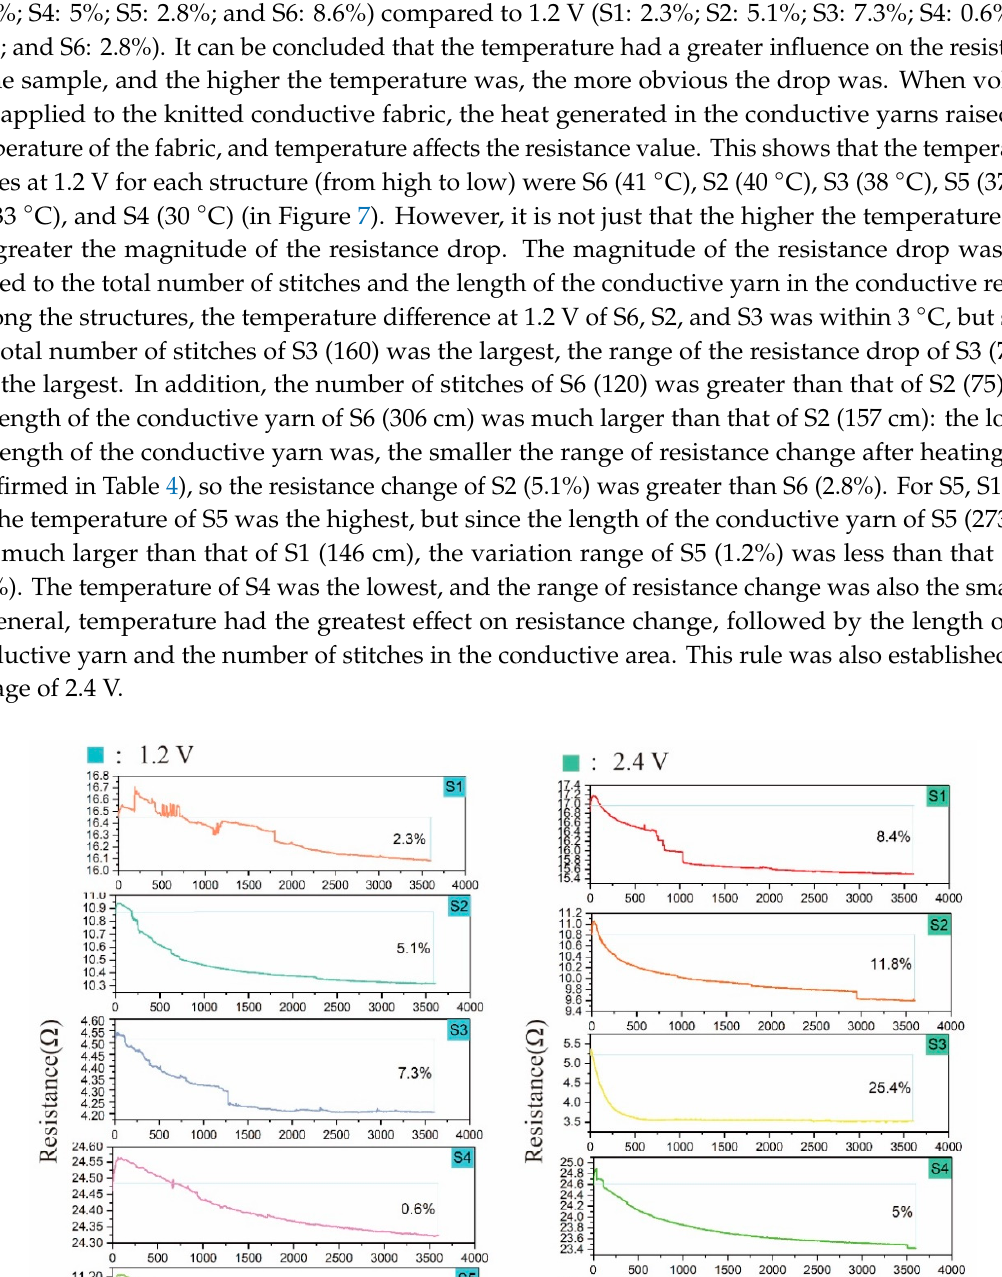
Figure 6. Current values of S1–S6 at 2.4 V in the first 10 s.